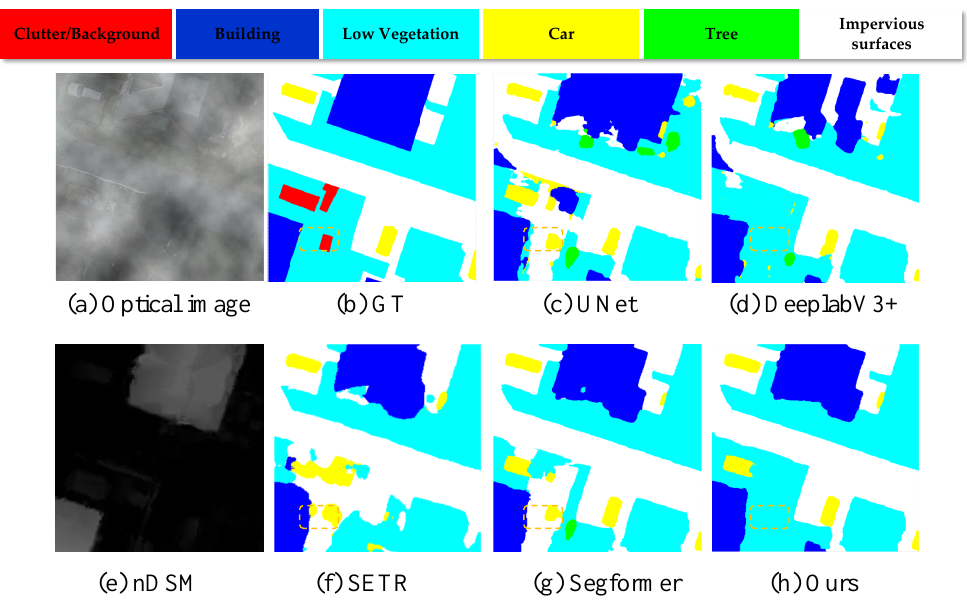
Figure 11. Qualitative comparisons between different methods applied to semantic segmentation of RSIs. The optical image is corrupted by the fourth severity level of fog.